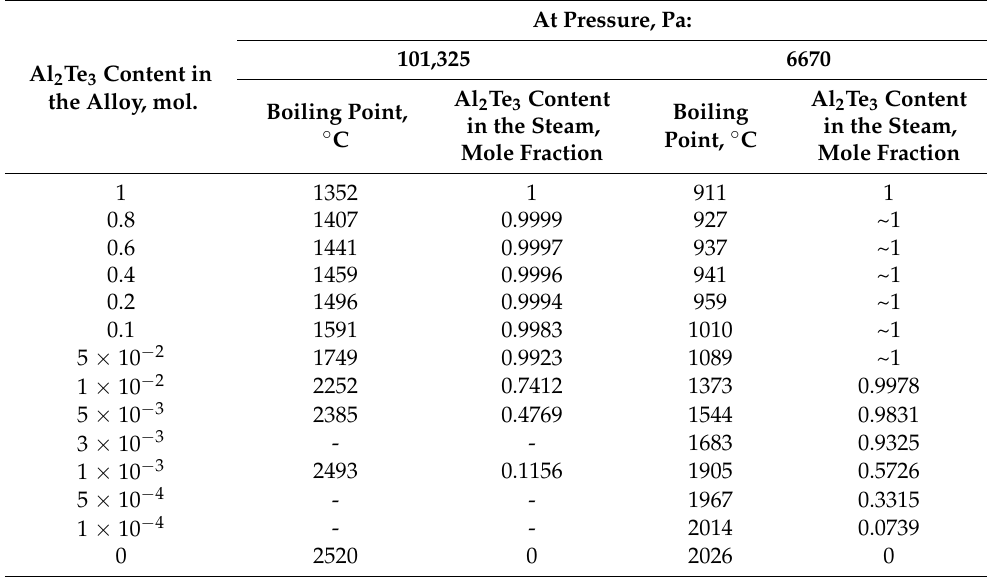
Table 2. Liquid-vapor phase transition boundaries of Al-Al 2 Te 3 system (0 ≤ x Al atmospheric and low pressures.